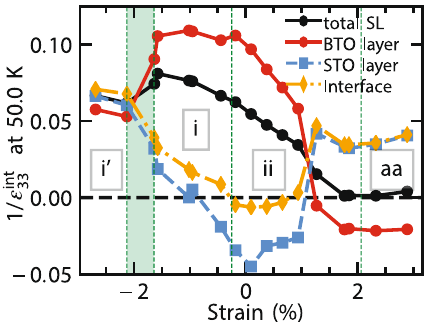
Fig. 2 Inverse local dielectric constant. Inverse local dielectric constant 1 = ε int of the BT (red circles), ST (blue squares), and layer interfacial (orange diamonds) layers for different strains at 50 K in the BT/ST SL (black circles).